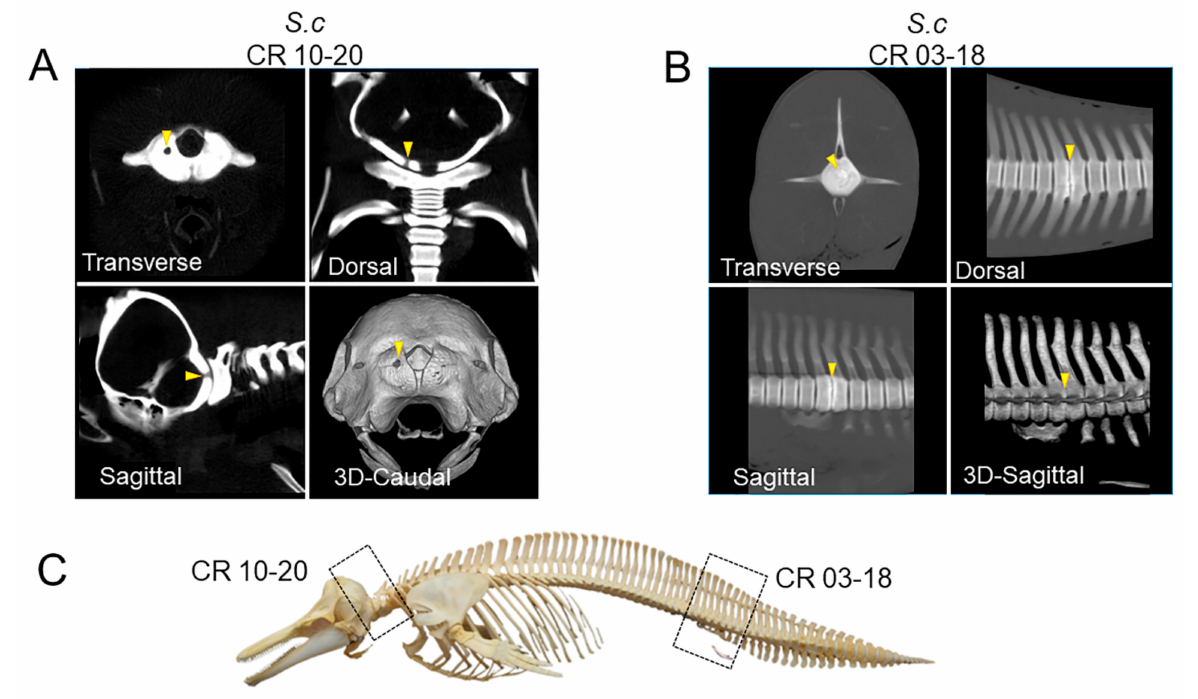
Figure 4. Reconstruction by PMCT of virtual cranial and spinal sections of adult dolphins with neurobrucellosis. ( A ) Transverse, dorsal, sagittal, and caudal views of the cranial bones and cervical vertebrae. The caudal view corresponds to a tridimensional reconstruction of the skull occipital region (3D). Yellow arrows indicate osteolysis of the occipital condyle in the different views. ( B ) Transverse, dorsal, and sagittal views of the tail bones showing fusion of Ca3 and Ca4 caudal vertebrae (yellow arrow). The sagittal view corresponds to the tail region’s tridimensional reconstruction (3D). ( C ) The planes of the corresponding virtual computed tomography sections are indicated in the punctuated rectangles. S.c , S. coeruleoalba. B. ceti was isolated from the osteolytic lesion in the occipital